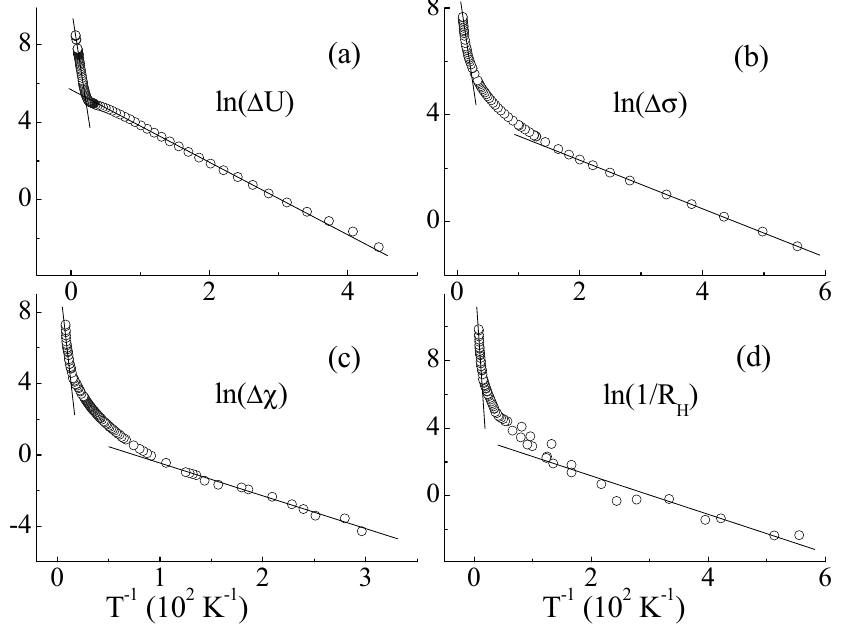
Figure 3. Change of regimes of thermal activation is a character feature of: two-level excitation density ( a ); conductivity ( b ); magnetic susceptibility ( c ); and inverse Hall effect ( d ) in the Al 63 Cu 25 Fe 12 phase.